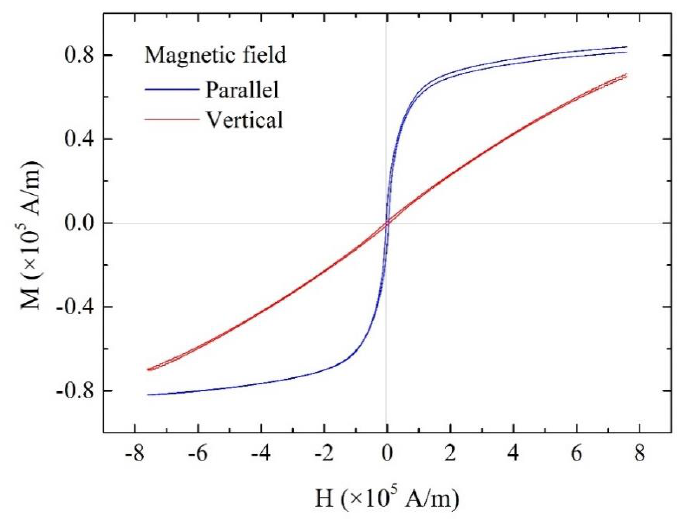
Figure 5. M–H curves of the discontinuous Fe-Co fiber / epoxy composite Figure 5. M – H curves of the discontinuous Fe-Co fiber/epoxy composite sheet.